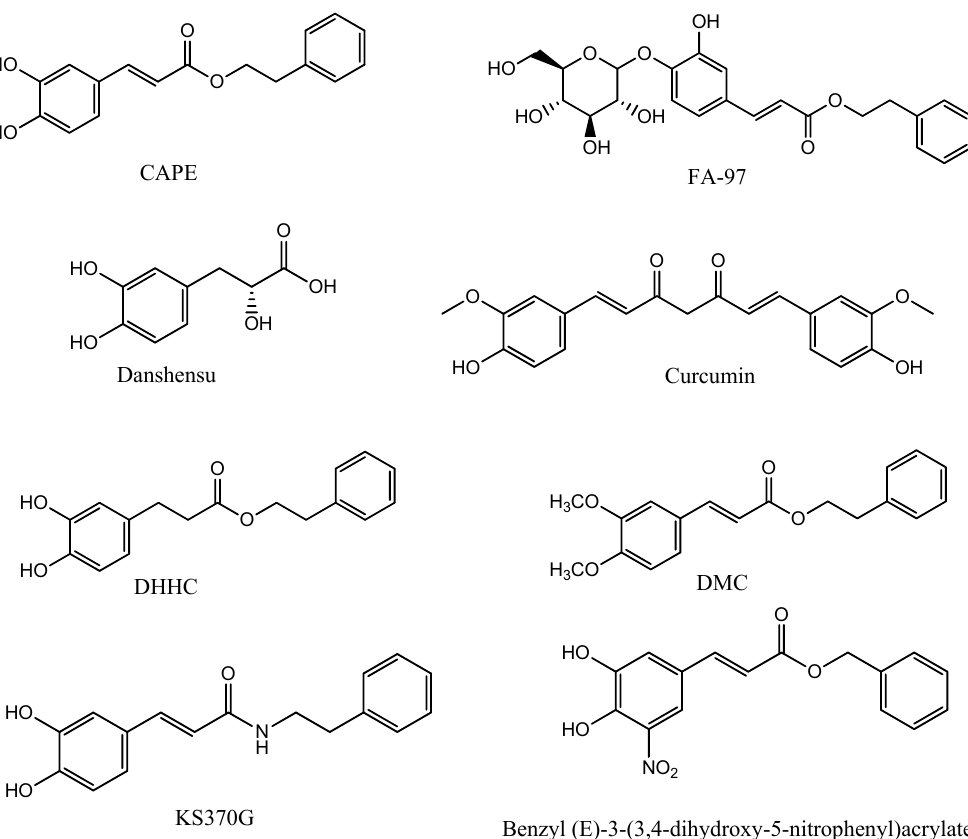
Figure 2. Chemical structure of CAPE and CAPE analogues.